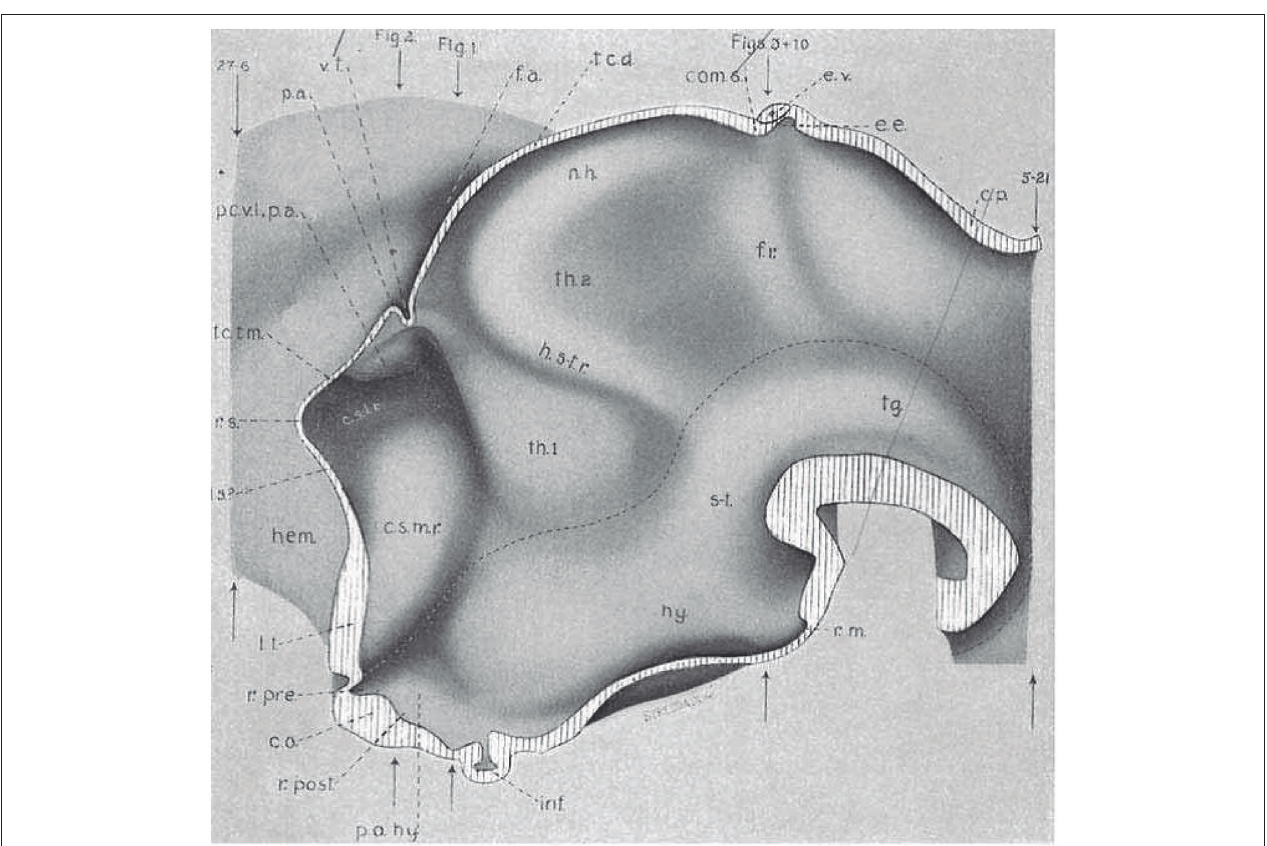
FIGURE 4 | Copy of a reconstruction of the ventricular surface of a 19mm human embryo published by Bailey (1916) (no copyright permission required). The axial reference is the sulcus limitans of His, an untagged dash line bending around the cephalic flexure and ending rostrally at the preoptic recess (r.pre). Modern versions of this limit, informed by neuronal differentiation markers and genoarchitectonic markers, instead make it end rostrally at the postchiasmatic recess (r.post), thus allowing the eye vesicles and the optic chiasma (c.o.) to represent alar structural elements. Kuhlenbeck proposed another variant with a rostral end of sulcus limitans at